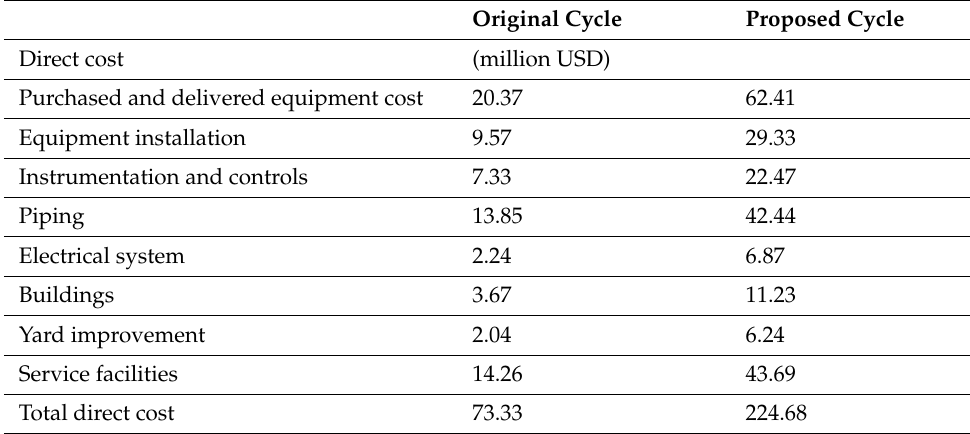
Table 6. Economic evaluation of the two cooling cycles.